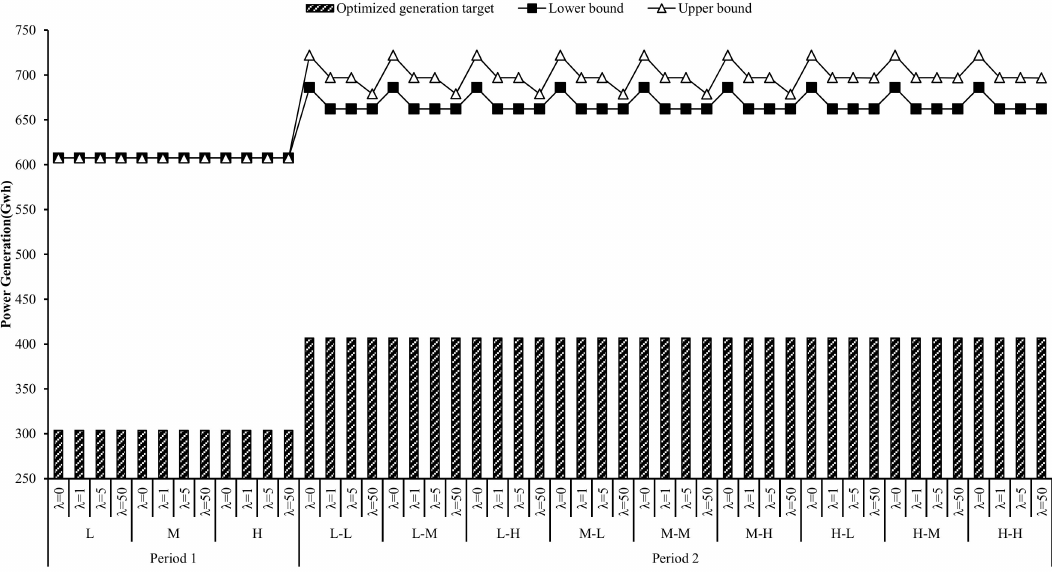
Figure 3. The optimized solar power generation amount in planning